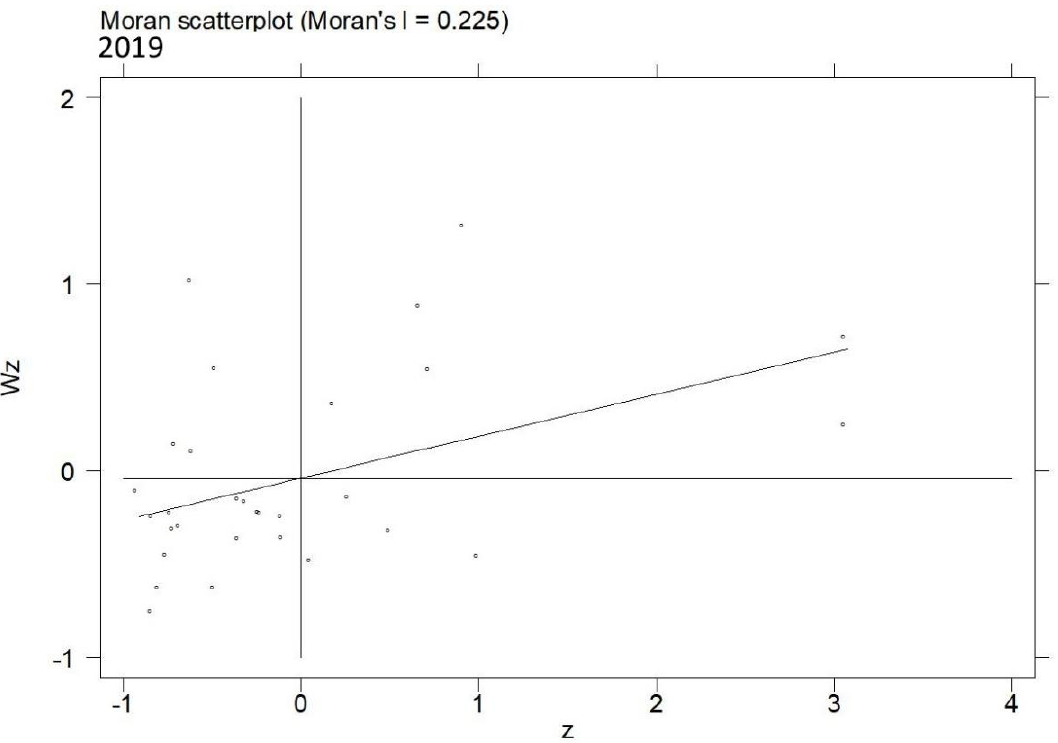
Figure 4. LISA of WRGUE in 30 provincial administrative units in 2009.